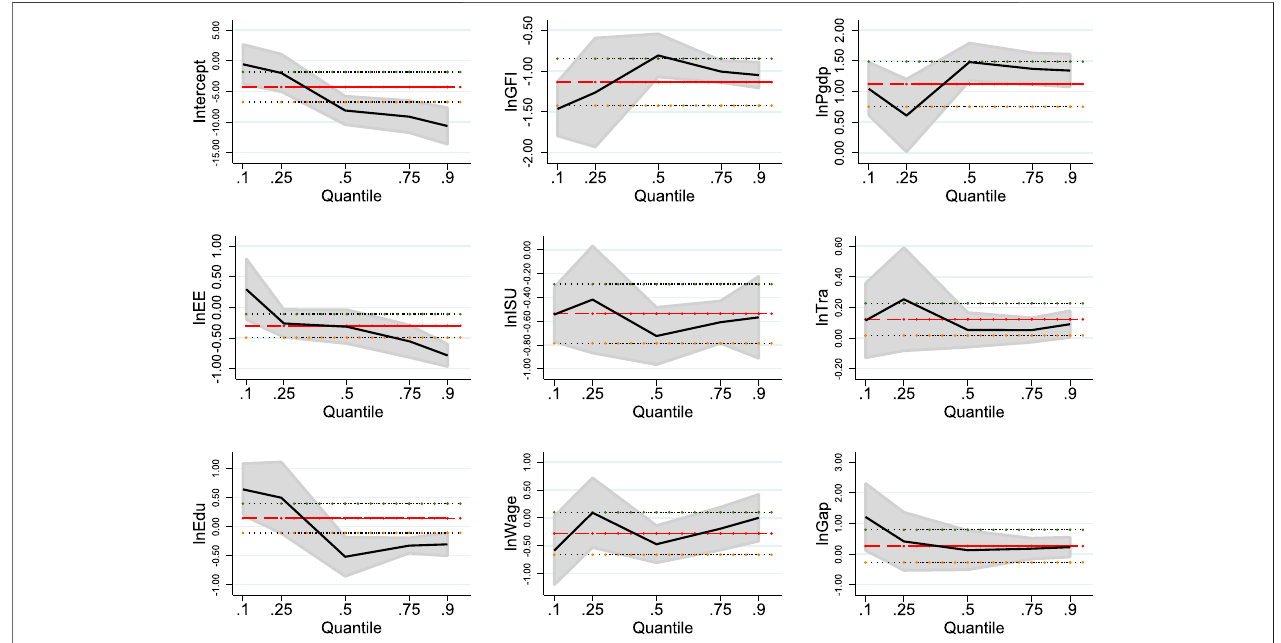
FIGURE 4 | Change in panel quantile regression coef fi cients. Notes: The x-axis represents the conditional quantiles of CO 2 emissions and y-axis denotes the coef fi cient values of various variables. The red line indicates the coef fi cient values of panel data model with fi xed effect.